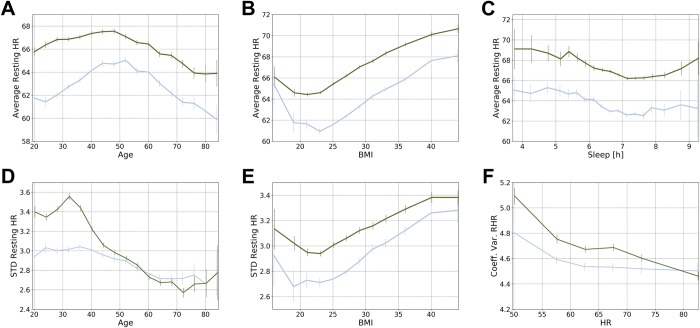
Influence of age (A), body-mass index (BMI) (B), and hours of sleep (C) on average daily RHR, influence of age (D) and body-mass index (BMI) (E) on the standard deviation (STD), and influence of the mean RHR on the coefficient of variation (Coeff. Var.) of the RHR (F). The average, the standard deviation, and the coefficient of variation of the average daily RHR are shown for individual women (green) and men (blue line) in the cohort. Vertical lines indicate 95% confidence intervals in the estimation of the average for each subgroup.